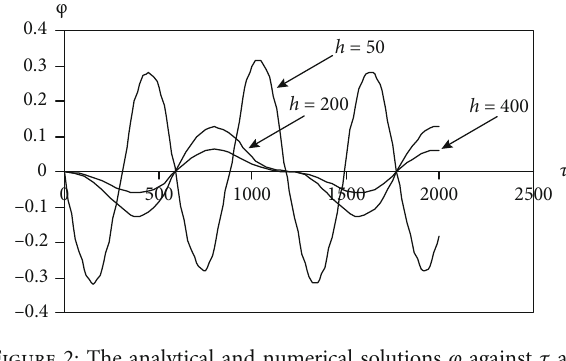
Figure 2: The analytical and numerical solutions φ against τ at h = 400 , 200, and 50.